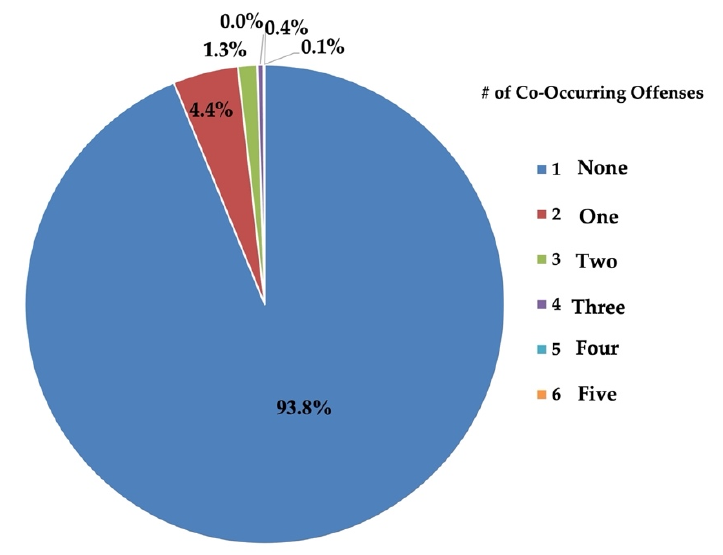
Figure 1. Animal Cruelty Co-Occurring Offenses.